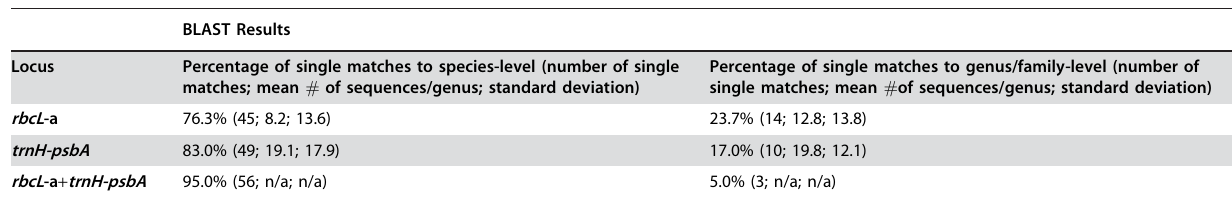
Table 3. GenBank BLASTn results of trnH-psbA and rbcL -a as a barcode tested singly and as a pair. .. ... .... ... ... .... ... ... .... ... ... .... ... ... .... ... ... .... ... ... .... ... ... .... ... ... .... ... ... .... ... ... .... ... ... .... ... ... .... ... ... .... ... ... . BLAST Results